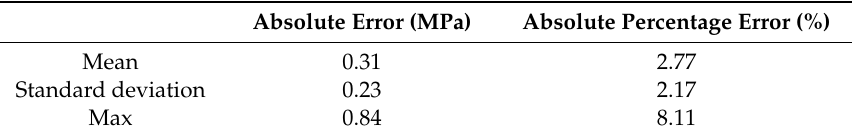
Figure 17. Comparison of the predicted and calculated BHP values. Table 6. Prediction errors for Process 3.